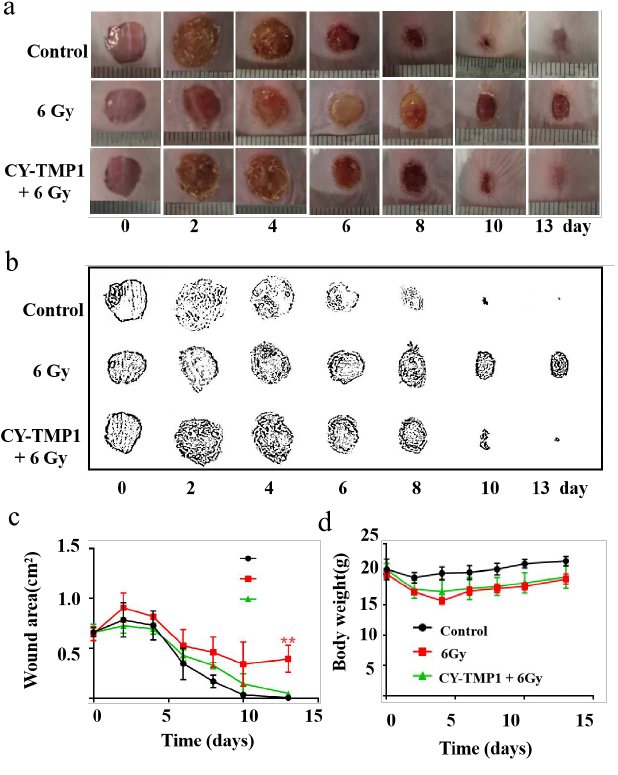
Figure 5. The effect of CY-TMP1 on wound repair with radiation-combined wound injury. ( a ) Representative photographs of wound repair at certain time points in different groups; ( b ) Visualization of representative photographs by Photoshop software (Photoshop CS 8.0.1, Adobe, CA, USA); ( c ) Quantitative measurement of wound area by Image J software ( n = 6; mean ± SD, ** p < 0.01 versus 6 Gy radiation-combined wound injury group); ( d ) Body weight of mice in different groups. There is no statistic difference in body weight at the end of the observation (on the 13th day), indicating tolerant treatment of CY-TMP1 without apparent acute toxicity.